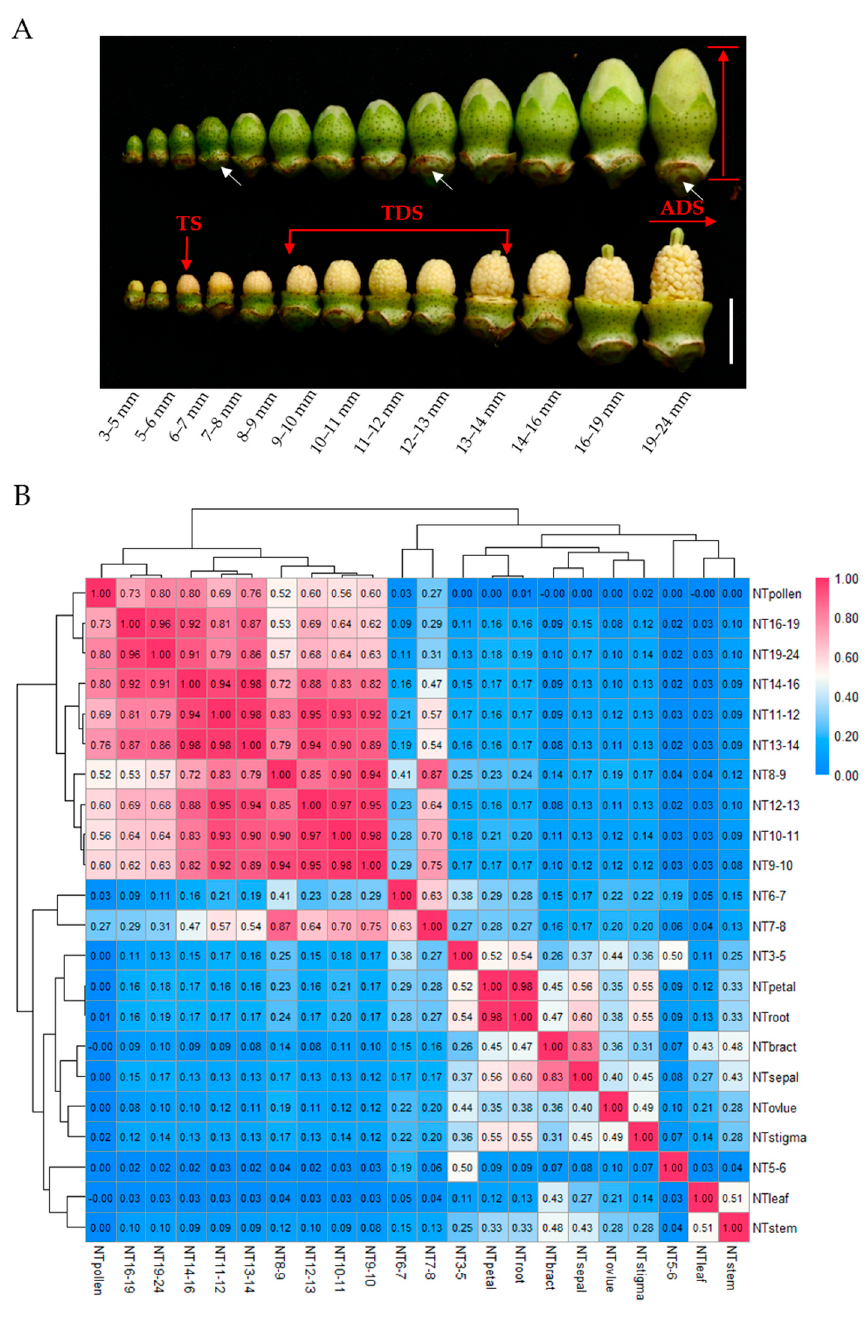
Figure 1. Phenotype of H05 anthers under Normal Temperature (NT) conditions and Pearson’s correlation coefficient r matrix of 22 sequenced tissues. ( A ) Phenotype of H05 anthers at different development stages under NT conditions. TS, tetrad stage (anther in 6–7 mm bud with tetrads). TDS, tapetal degradation stage (anther in 9–14 mm bud with uninucleate microspores or binucleate microspores). ADS, anther dehiscence stage (anther in 19–24 mm and ≥ 24 mm bud with mature pollen grains). The white arrow represents the nectary. Bud length: from the nectary to the top of the bud. Scale bars = 1 cm; ( B ) Pearson’s correlation coefficient r matrix of 22 sequenced tissues under NT conditions. TPM values for the transcripts of 70,199 genes were used to perform this correlation analysis. Pearson’s correlation coefficient r was calculated by R language and filled as numbers in this matrix. Pearson’s correlation matrix was drawn by heatmap software. Twenty-two sequenced tissues of H05: mature pollen at anthesis under NT (NTpollen), anther in 3–5 mm bud under NT (NT3-5), anther in 5–6 mm bud under NT (NT5-6), anther in 6–7 mm bud under NT (NT6- 7), anther in 7–8 mm bud under NT (NT7-8), anther in 8–9 mm bud under NT (NT8-9), anther in 9– 10 mm bud under NT (NT9-10), anther in 10–11 mm bud under NT (NT10-11), anther in 11–12 mm